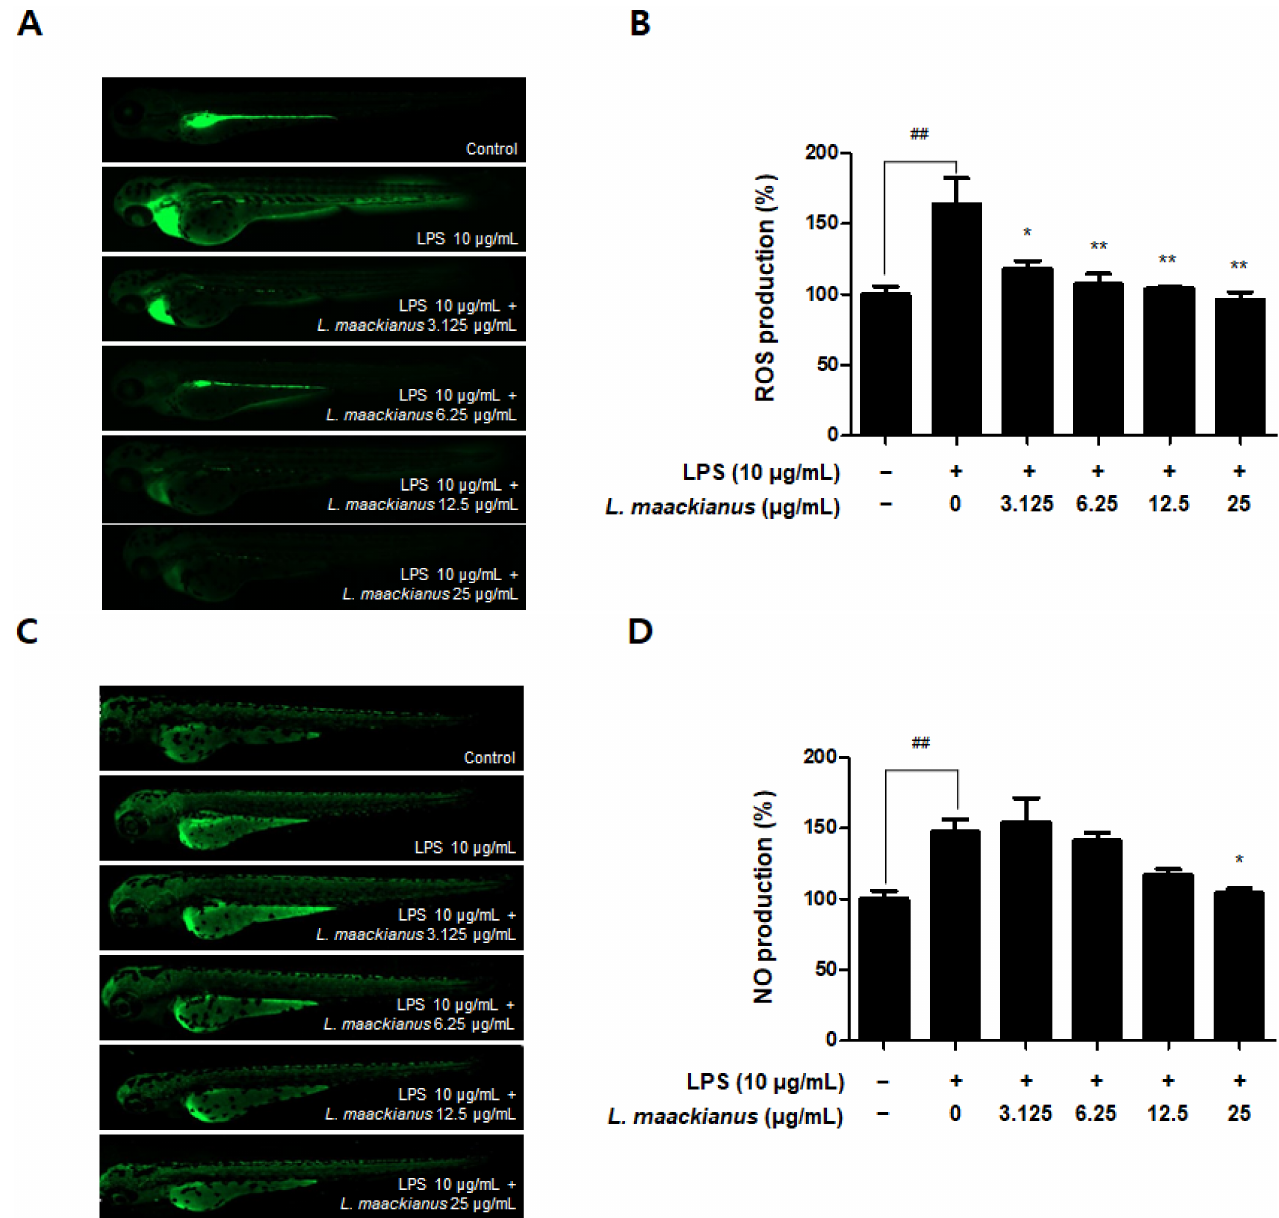
Figure 10. Reactive oxygen species (ROS) ( A , B ) and nitric oxide (NO) generation inhibitory effect ( C , D ) of L. maackianus MeOH extract in lipopolysaccharide (LPS)-treated zebrafish model. Results were obtained after 7 d of treatment with 10 µ g/mL LPS and extract (3.125–25 µ g/mL). Data are presented as mean ± standard deviation for three independent experiments. Unprocessed controls were included. ## p < 0.01 compared to control. * p < 0.05, ** p < 0.01 compared with LPS-treated